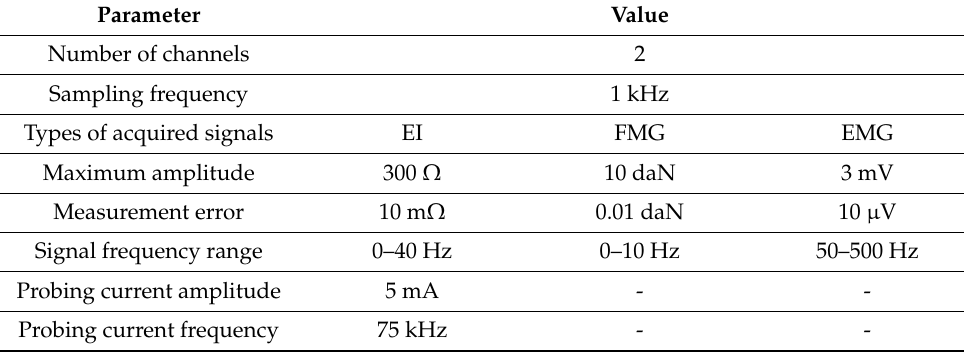
Table 1. Technical parameters of the laboratory